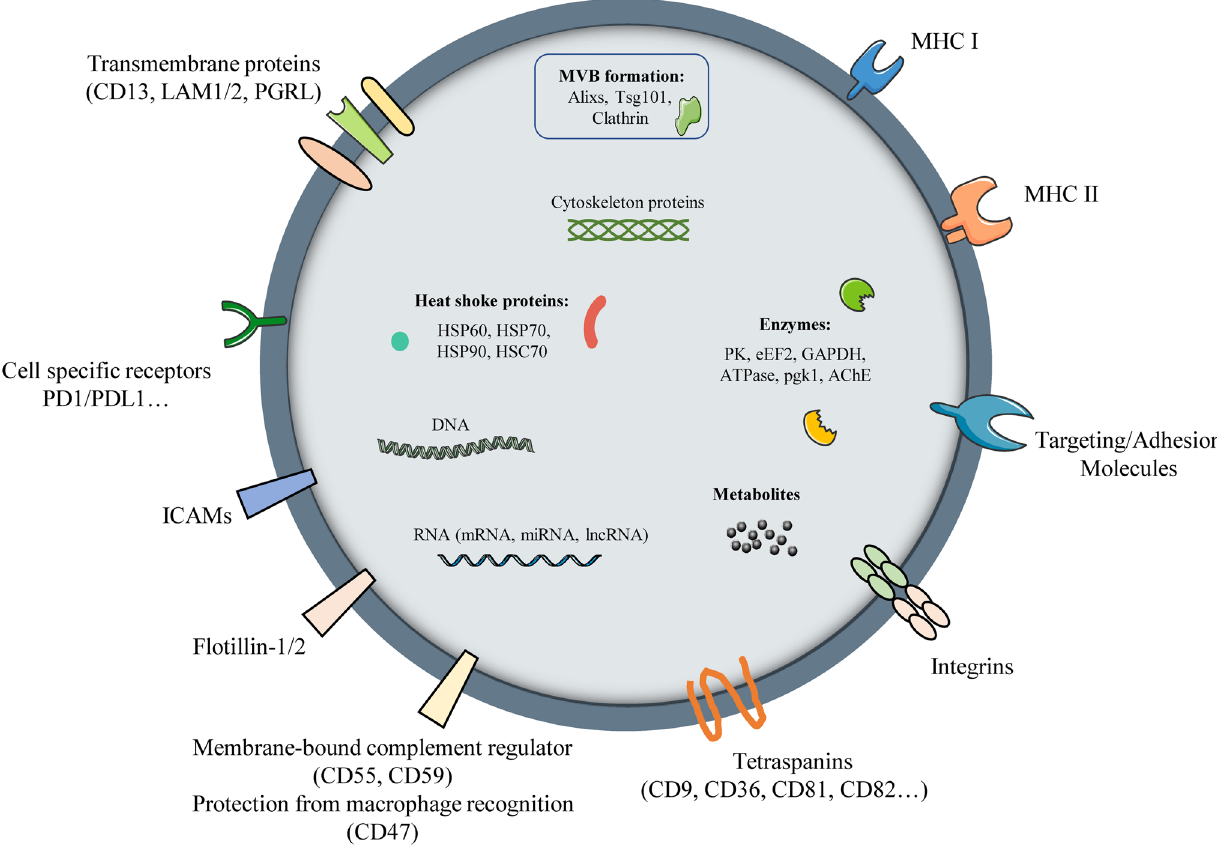
Fig. 2 Schematic diagram of exosomes. The membrane and inside of exosomes carry a variety of proteins (CD13, LAM1/2, PGRL, PD1, PDL1, et al.), metabolites and nucleic acids (mRNA, miRNA, lncRNA, et